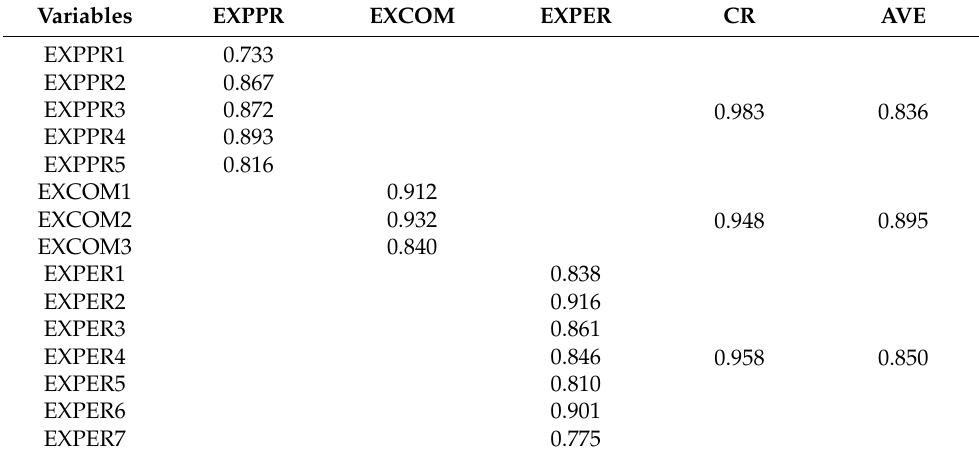
Table 1. Factor Loading and convergent validity.